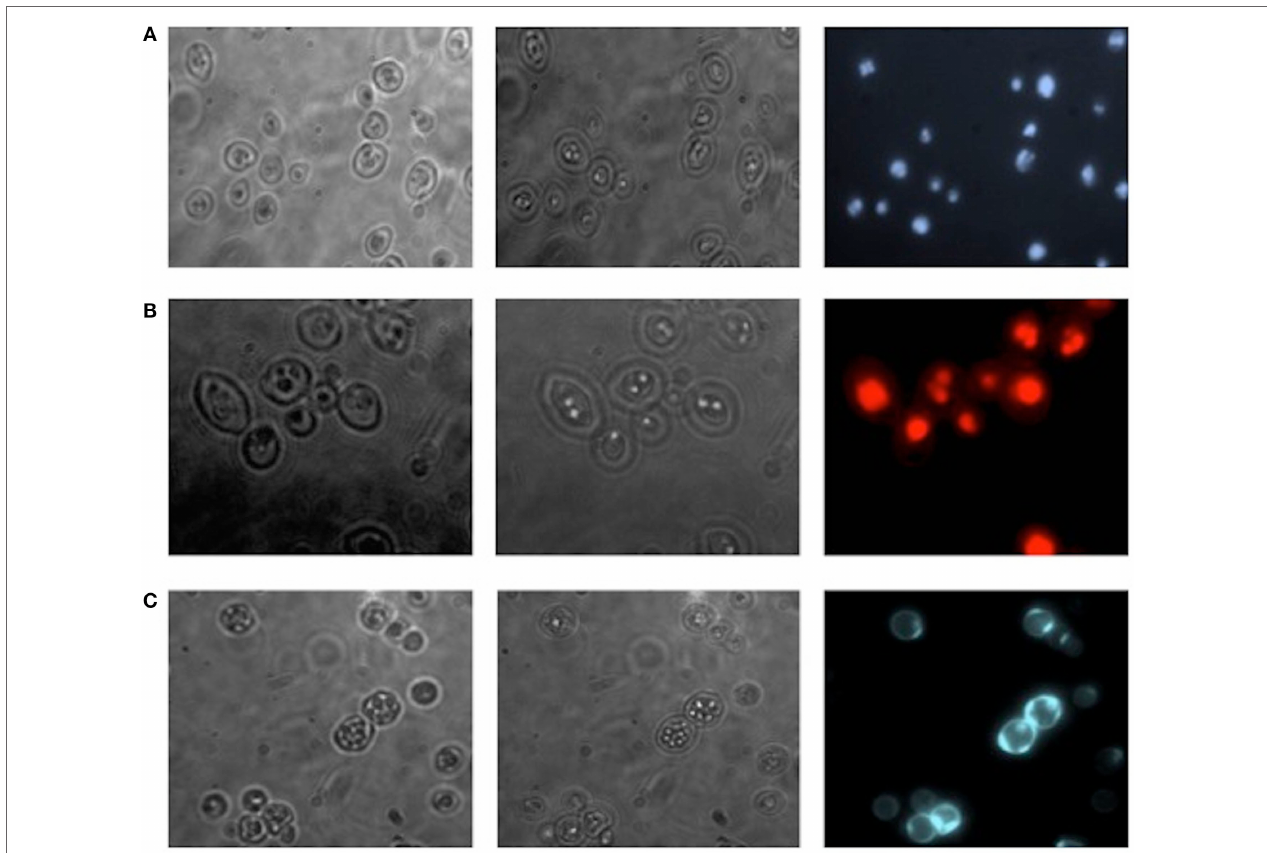
FigUre 3 | Fluorescent microscopy of aged (3 weeks old) NUP-TOP translocants. The spherical bodies, whose number increased with aging, can be visualized also without fluorescence using different focus lengths (the first two pictures of each panel), but they become more evident after staining with DAPI (a) and Pyronin Y (B) . After 4 weeks, all the cells of all the TNTs translocant strains contain a variable number of SBs. Cell aging is testified by the numerous scars on the cell wall that are visible after calcofluor treatment (c)